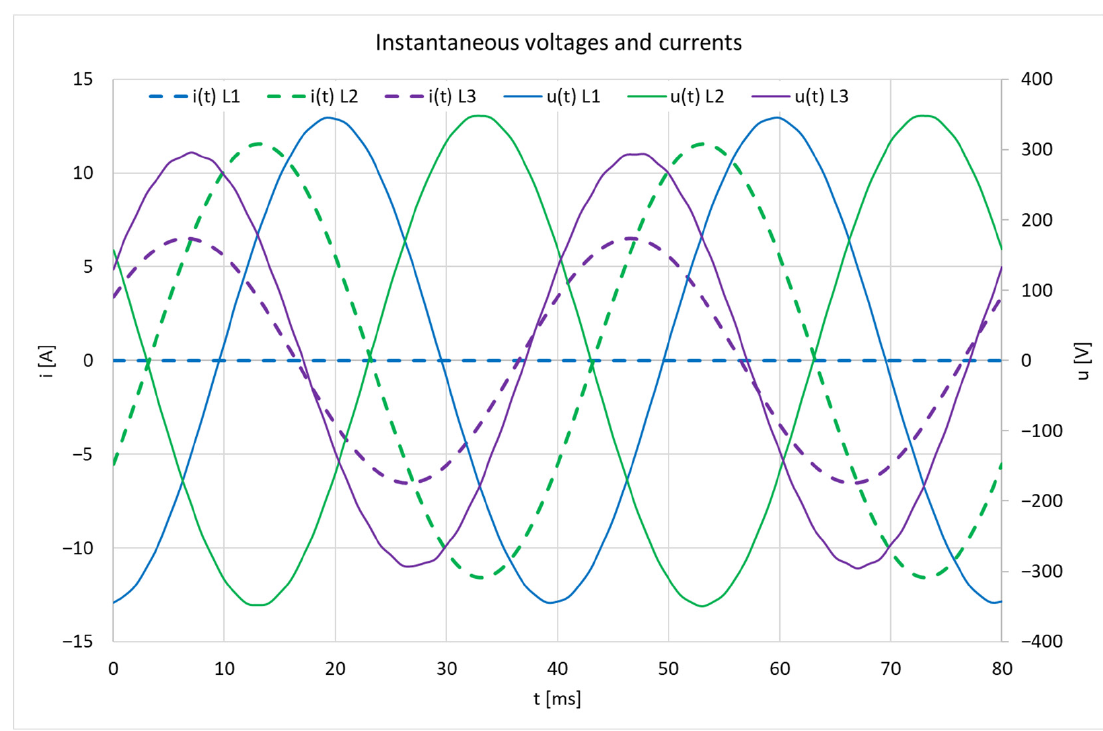
Figure 8. Instantaneous currents and voltages collected in the 10th hour of simulation in a single prosumer installation, reference case.